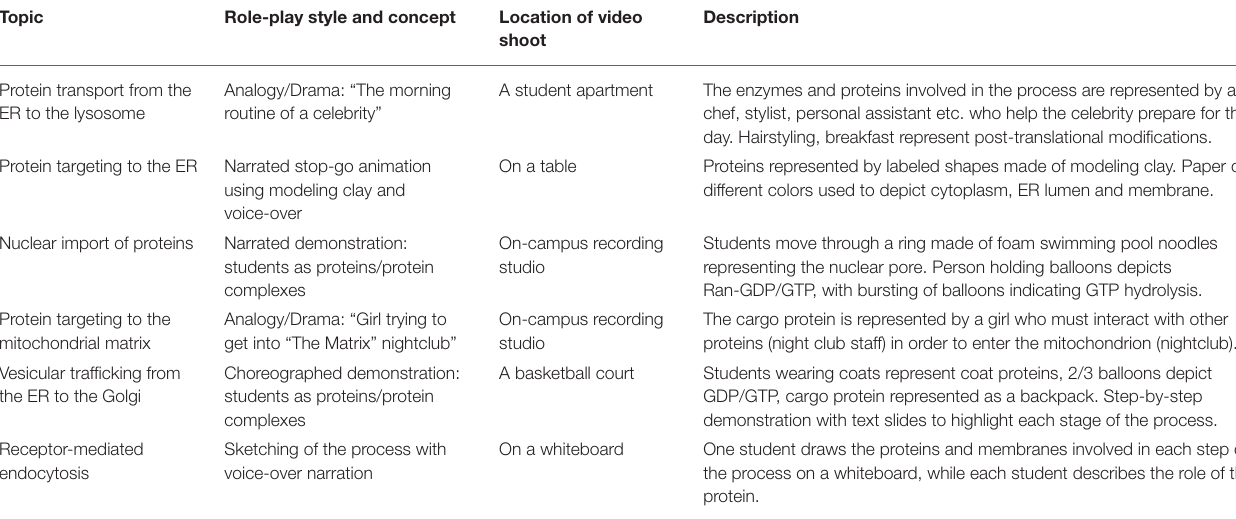
TABLE 2 | Categorization of